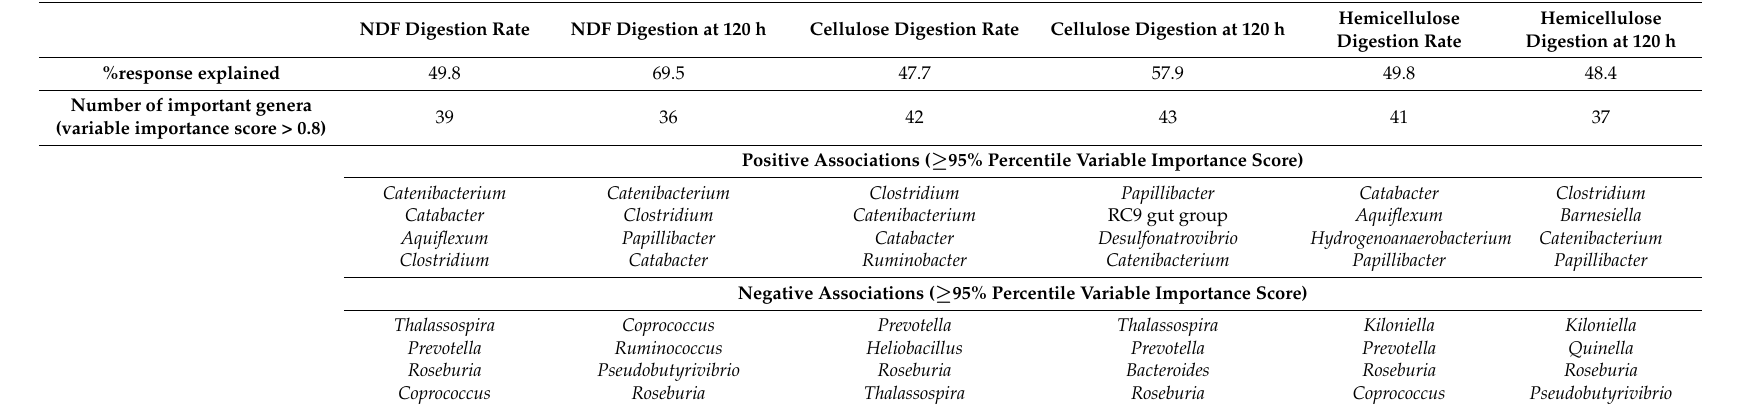
Table 4. Main bacterial genera associated with fiber digestion in hay.